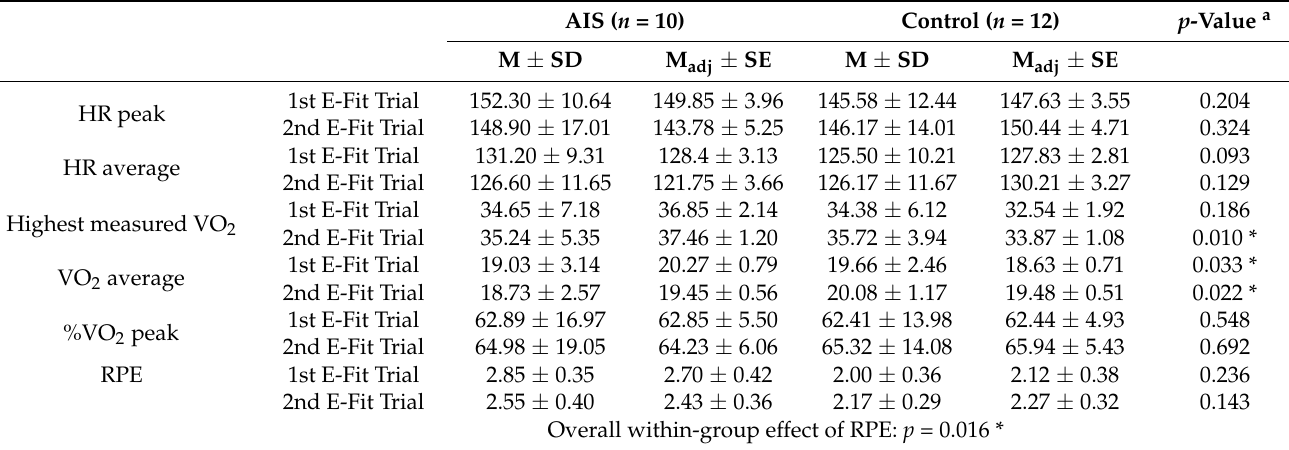
Table 3. Mean, adjusted mean, standard deviation and standard errors for metabolic demand between AIS and control groups when performing E-Fit